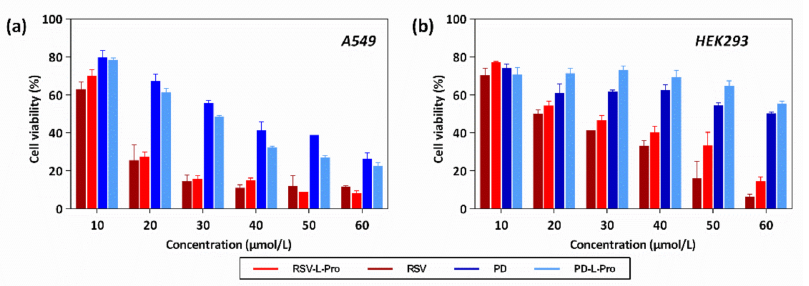
Figure 10. The cell viability data of RSV, PD, and the crystals of RSV-L-Pro and PD-L-Pro against human lung cancer cell line A549 ( a ) and human kidney cell line HEK-293 ( b ) upon culturing for 24